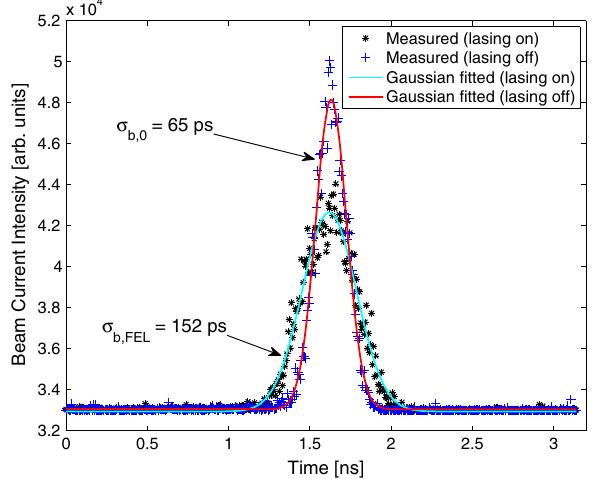
FIG. 6. Electron beam bunch length measurements in the two- color operation with the four-undulator configuration and loss curves L2 (Run 3). The data points marked by “ star ” and “ plus ” represent the measured longitudinal profiles of the electron bunch with the lasing turned on and off, respectively. The data are fitted using Gaussian distribution (solid curves). The measured dis- ¼ 69 ps. The FEL is operated at λ sector resolution σ b; res 712 . 31 nm and λ ¼ 367 . 01 nm. The beam current is 12.34 2